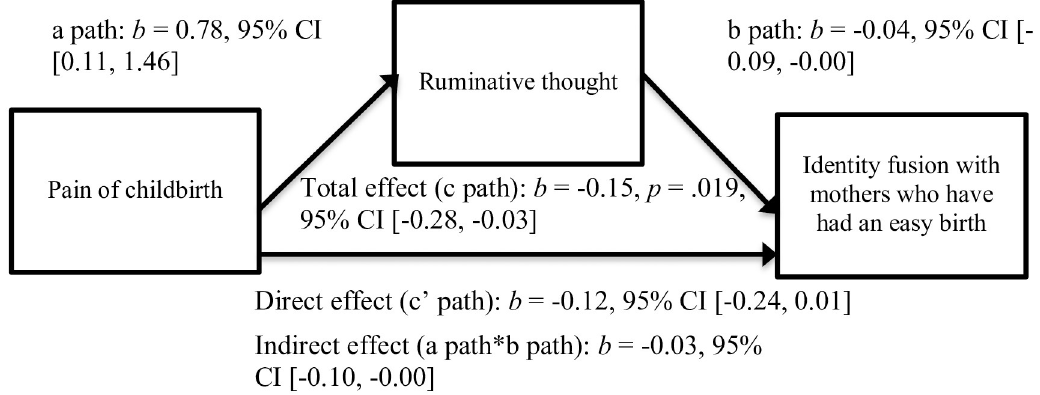
Fig 4. Mediation model of fusion with mothers who had an easy birth via pain levels and ruminative thought.